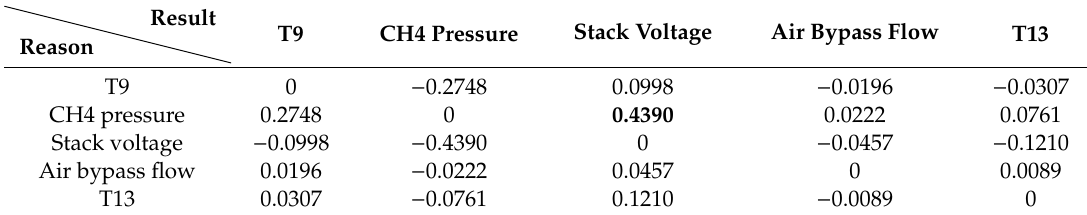
Table 2. Results of transfer entropy.